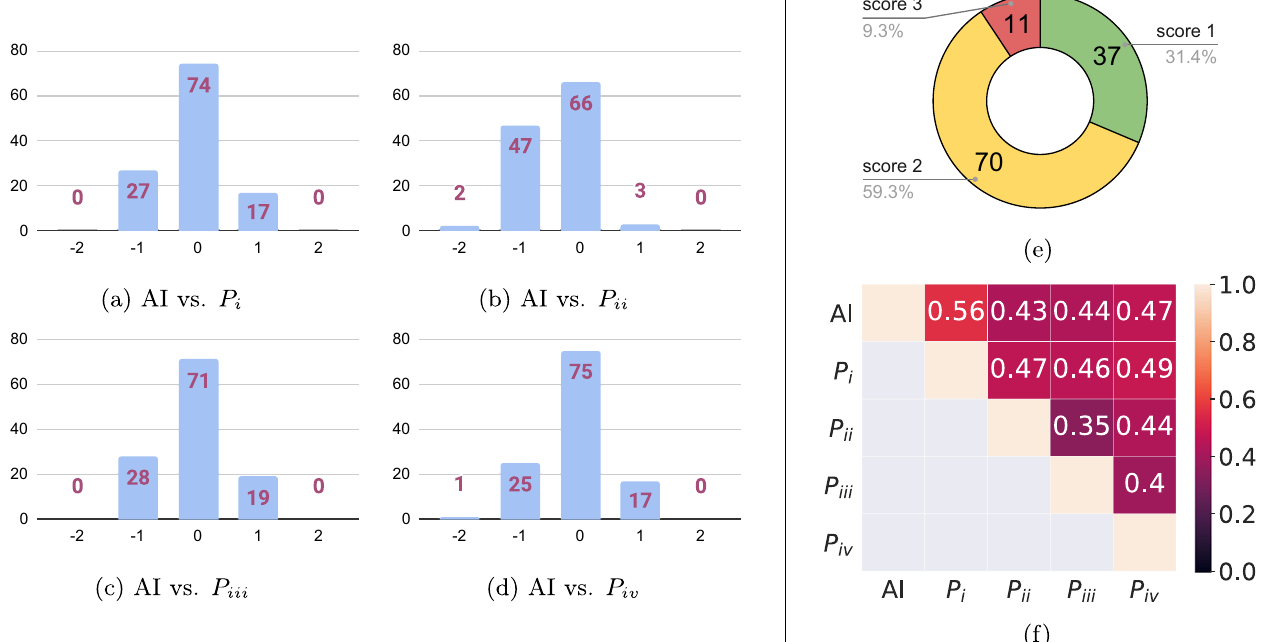
Fig. 7 Performance evaluation of the AI algorithm on the 118 whole-slide images in the slide-study. For comparison purposes, the scores of the AI algorithm were quantized into three categories. The score differences of AI algorithm from the four pathologists are presented through a to d , while its score distribution is shown in e . The AI algorithm and the fi rst pathologist, P i , had the highest agreement ( f ) with AI being only second to P i on average pairwise kappa the abnormalities of tumor nuclei in breast cancer, curated data sets representative of the label space with domain-speci fi c data augmentations enable DL solutions to achieve high performance. In routine clinical practice, nuclear pleomorphism scoring of